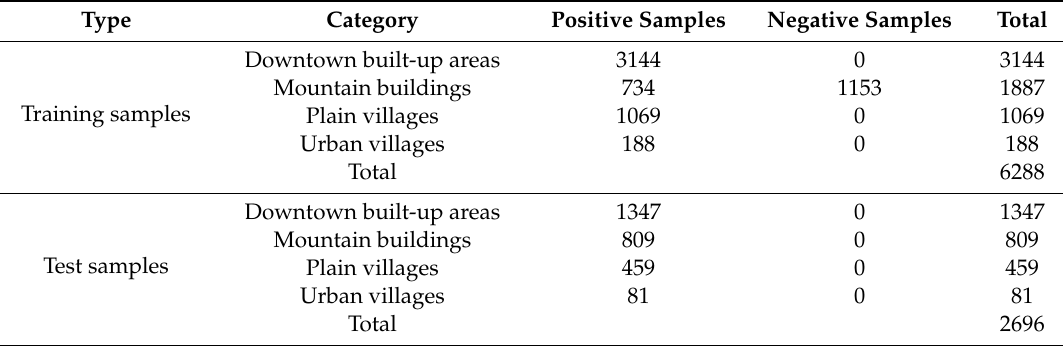
Figure 6. Multicategory-labeled samples. ( a1 – f1 ) Google Earth image slices; corresponding ( a2 – f2 ) SAR image slices and ( a3 – f3 ) pixel-level-labeled samples. Line ( a ) indicates downtown built-up areas; line ( b ) indicates mountain villages; line ( c – e ) indicates plain villages; line ( f ) indicates urban villages. Table 3. Basic information of training data and test data.